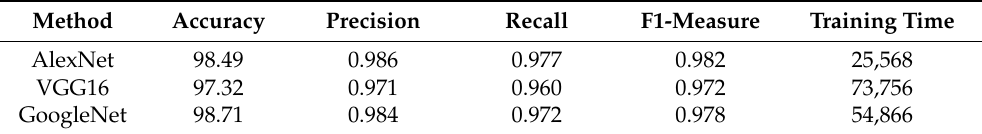
Table 2. Experimental results using the most well-known deep learning-based CNN models.